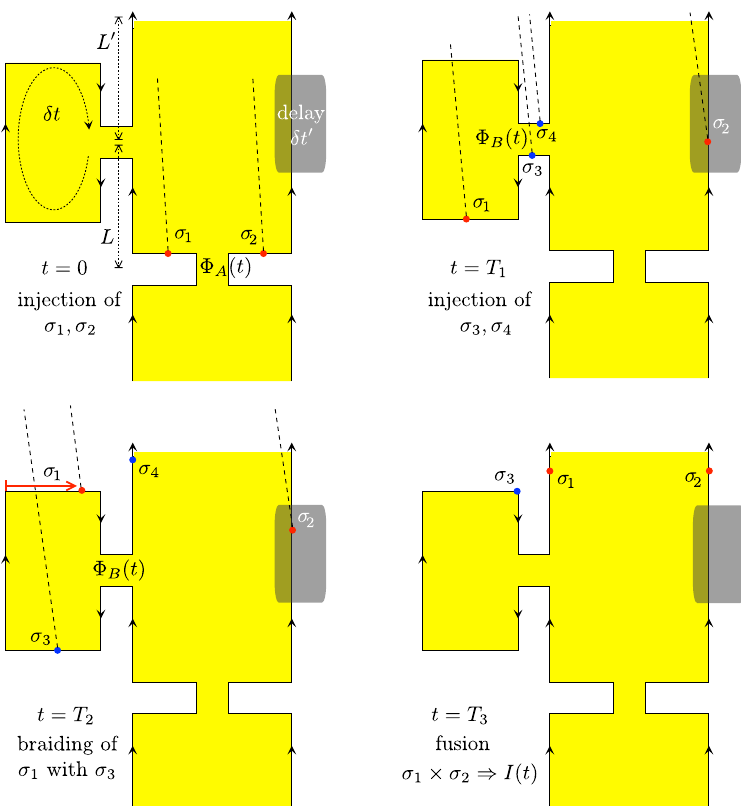
Figure 7: Four steps in the braiding of vortices σ and σ moving in opposite direc- 1 3 tions. In the top two panels two pairs of edge vortices are injected by a flux pulse: first vortices σ and σ at time t = 0, then vortices σ and σ at time t = T . Vortex 1 2 3 4 1 σ is delayed by a time δ t (cid:48) along the right edge, to compensate for the longer path 2 length of vortex σ along the left edge. In the lower-left panel vortex σ crosses the 1 1 branch cut of vortex σ , effectuating the braiding operation. In the lower-right panel 3 vortex σ has caught up with vortex σ and the current I ( t ) is measured at t = T , 1 2 3 to detect the braiding via a charge